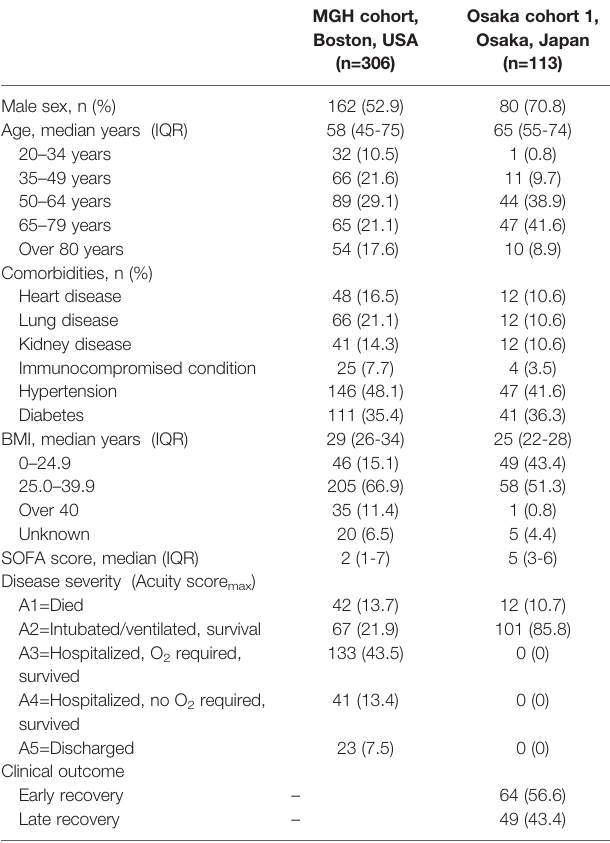
TABLE 1 | Clinical and Demographic Characteristics of COVID-19 Patients in the MGH Cohort and Osaka Cohort